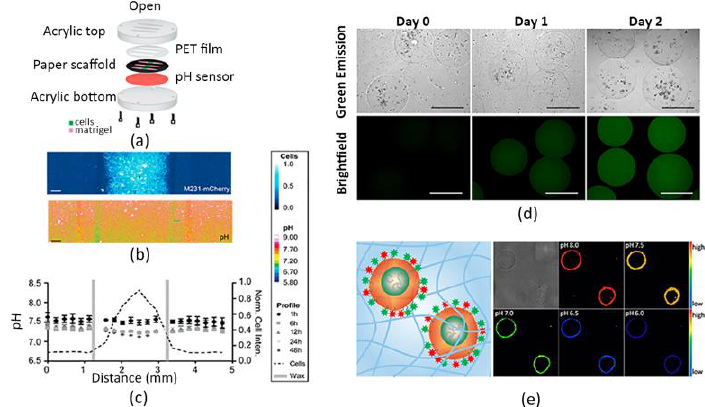
Figure 1. pH monitoring. ( a ) Representative illustration of the sensing culture platform containing the pH-sensing film assembled with a paper-based cell culture. ( b ) Fluorescence images of the engineered breast cancer cells cultured in delimited regions of the paper-based scaffold and corresponding heat maps showing the pH values spatial distribution. Scale bars are 250 µ m. ( c ) Average pH profiles within the cell culture system over 48h, represented as mean and standard deviation of three different cell cultures. The dotted lines indicate the cells-seeded areas in the paper-based system. ( d ) Brightfield (top) and fluorescence images (bottom) of polyethylene glycol (PEG) microgels encapsulating HeLa cells and carbon dots pH nanoprobes over time; fluorescent signal intensity increasing over time indicate a decrease in pH level within the hydrogel cultures. Scale bar is 500 µ m. ( e ) Representation of HeLa cells provided with surface-anchored lipid-DNA pH sensing probes embedded in a 3D collagen hydrogel (left); fluorescence signal emission in various pH extracellular levels. Signal intensifies with the increasing of pH values (right). ( a – c ) Adapted and reprinted with permission from [107]. Copyright (2018) American Chemical Society; ( d ) Adapted and reprinted with permission from [108]. Copyright (2017) American Chemical Society; ( e ) Reprinted with permission from [112]. Copyright (2014) American Chemical